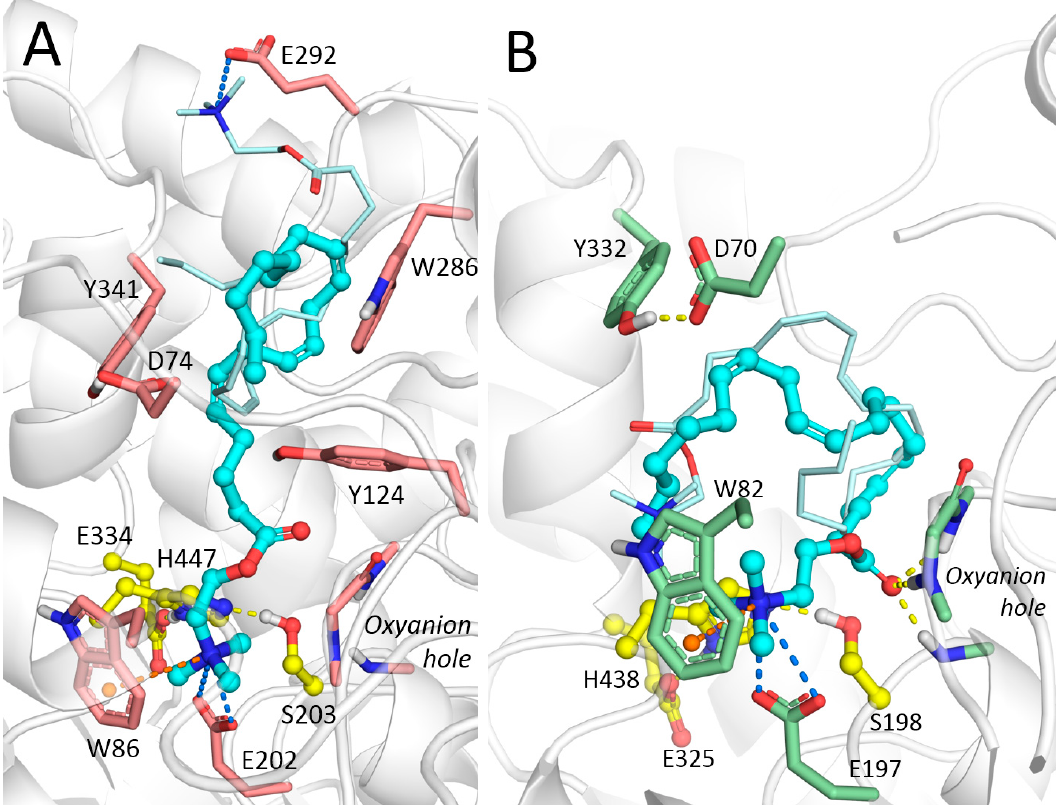
Figure 7. Docked poses of AA-CHOL inside ( A ) AChE and ( B ) BChE gorges. The best binding pose of AA-CHOL is shown with balls and sticks, carbon atoms colored cyan, poses in the PAS (for AChE) and outside active site (for BChE) are shown with lines, carbon atoms colored pale cyan.